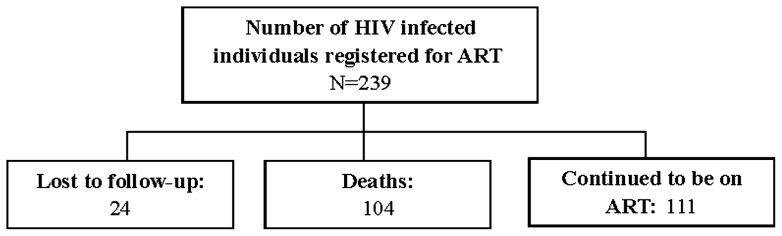
Flow chart depicting status of HIV infected individuals who were put on ART at the end of study period.